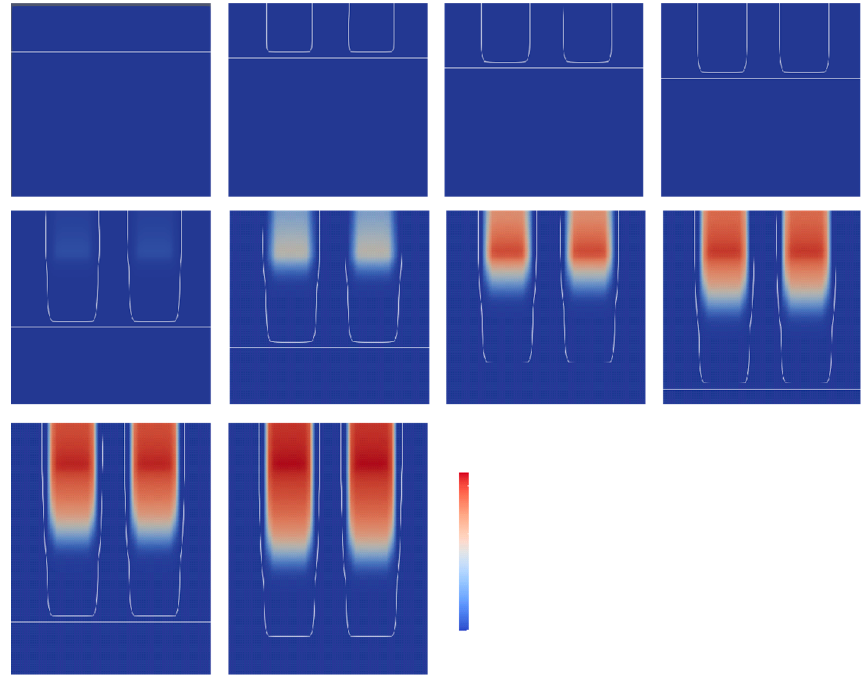
Figure 6. Contour plot of normalized oxygen concentration of 0.9 and C=C bond conversion distribution at a lift-up speed of 1 mm/s. Notice: the color bar of conversion has a different range from that in Figure 2. The maximum range of the color bar is 50 times smaller than that in Figure 2.